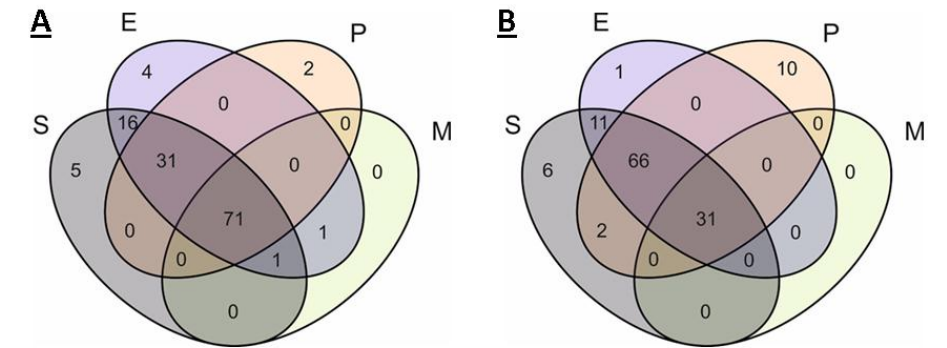
Figure 7. Venn diagram of the occurrence of different KEGG pathways in the pangenome ( A ) and core genome ( B ) in organisms. S, E, P, and M indicate ellipses corresponding to S. aureus , Enterobacter spp., P. aeruginosa , and Mycoplasma spp.